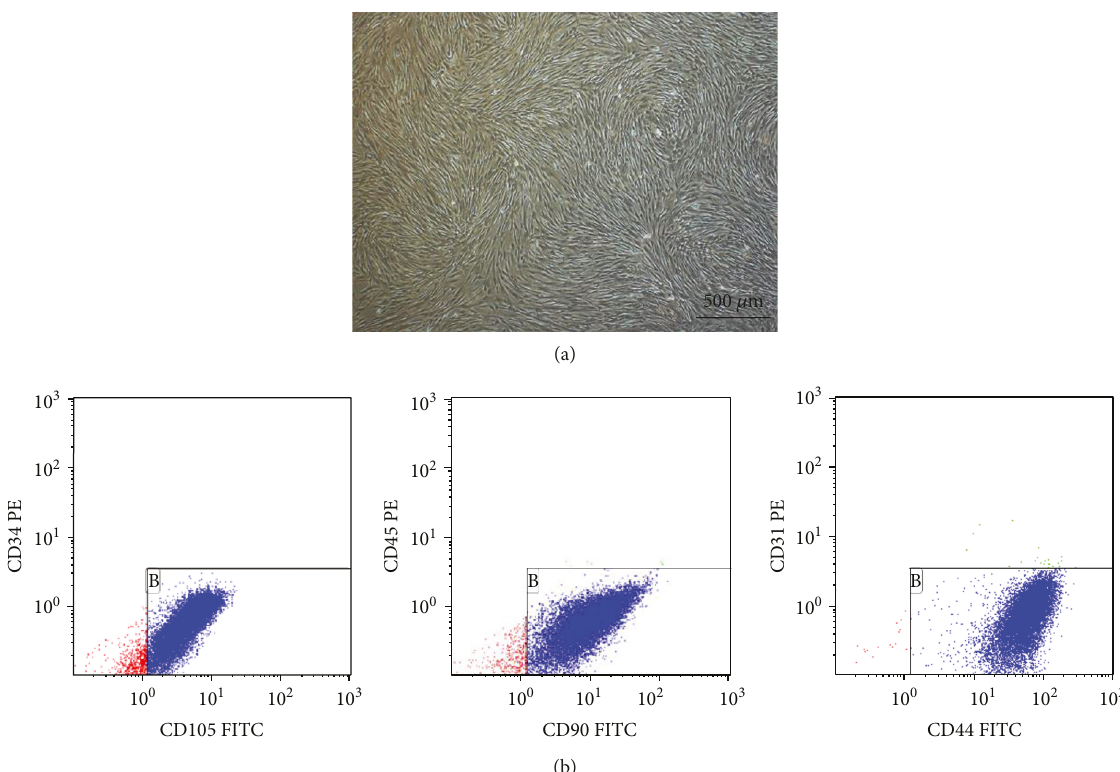
Figure 1: Characterization of hUC-MSCs. (a) Morphology of passage 3 hUC-MSC identi fi cation of human umbilical cord mesenchymal stem cells. (b) Flow cytometric analysis showing the immunophenotype of the passage 5hUC-MSCs. The cells were positive for CD105 (96.4%), CD44 (99.6%), and CD90 (97.6%), but negative for CD34, CD31, and